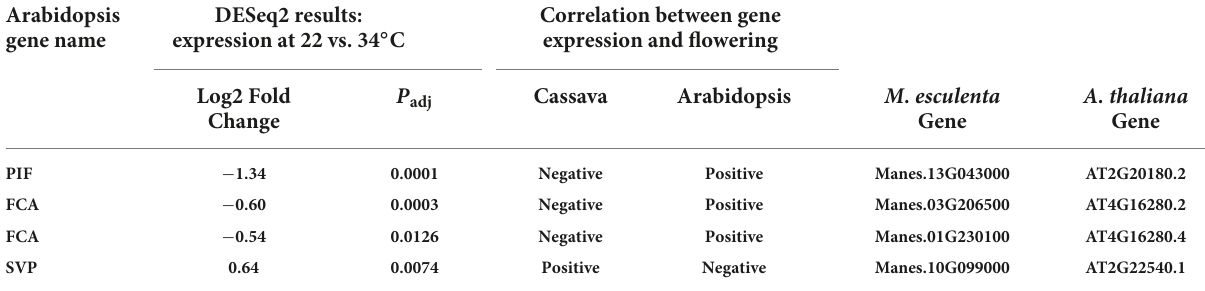
TABLE 2 Significant differentially expressed genes (DEGs) and log2 Fold Change of core downstream genes in the ambient temperature pathway. Arabidopsis gene